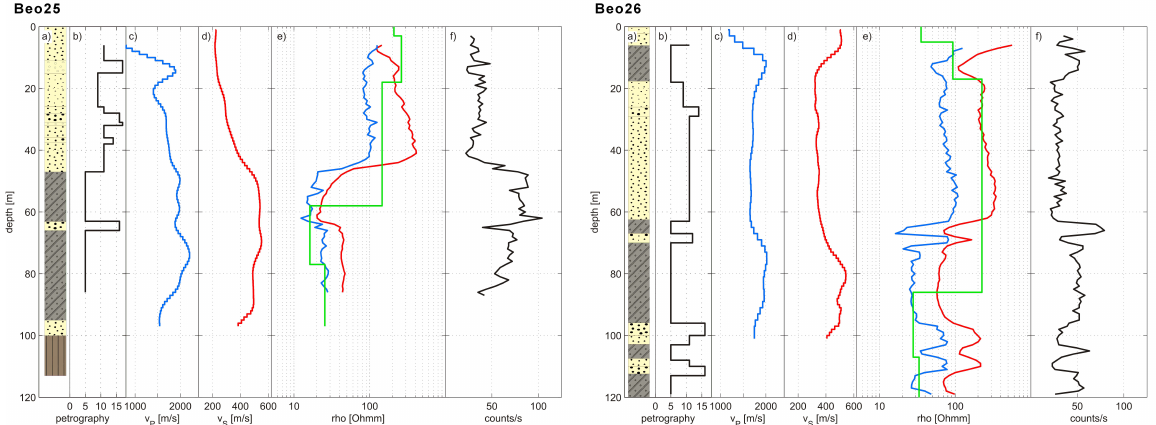
Fig. 3. Example logs for borehole Beo25 (left panel) and Beo26 (right panel) (see Fig. 1c): (a) lithology (see Fig. 2); (b) petrographical classification (see Table 2); (c) P-wave seismic interval velocity from VSP; (d) S-wave seismic interval velocity from VSP; (e) resistivity values for long-normal 64 00 (red), FEL (blue) and nearby SkyTEM inversion model (green) with offset (Beo25: 177m; Beo26: 13m); and (f) gamma ray log. Note that the SkyTEM resistivity values do not fit exactly to the resistivity logs due to the horizontal offset of the SkyTEM data points and the large integration volume of this method. For Beo25 the two till layers differ in resistivity as well as gamma log.